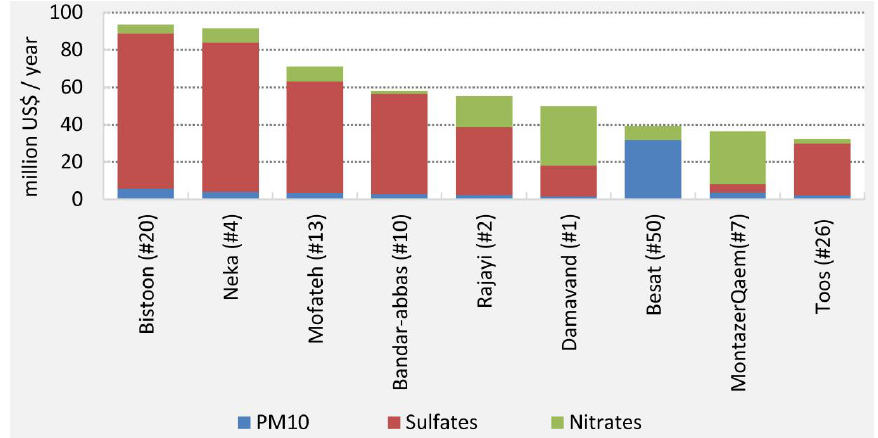
Figure 7. Top nine plants at the health damage costs with respect to the type of pollutants (million USD/year).